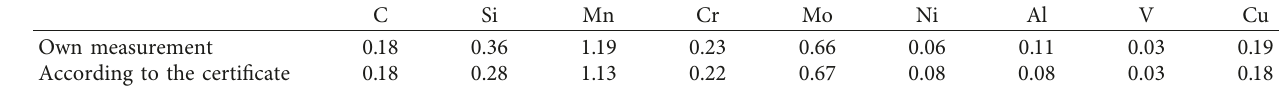
Table 1: Chemical composition of S960QL steel.